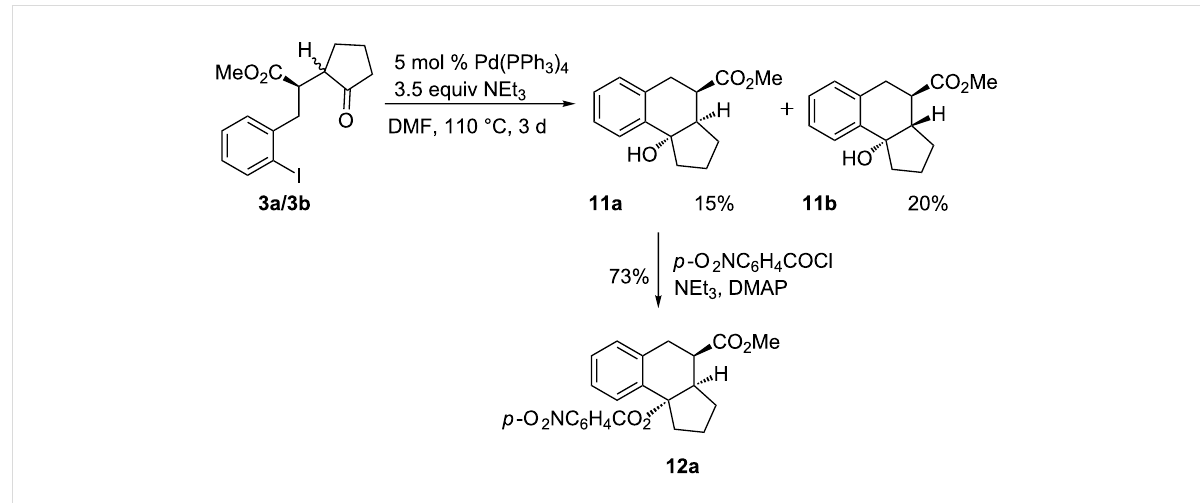
Scheme 4: Palladium-catalyzed cyclization of diastereomeric cyclopentanone derivatives 3a/3b to products 11a and 11b and synthesis of p -nitro- benzoate 12a .